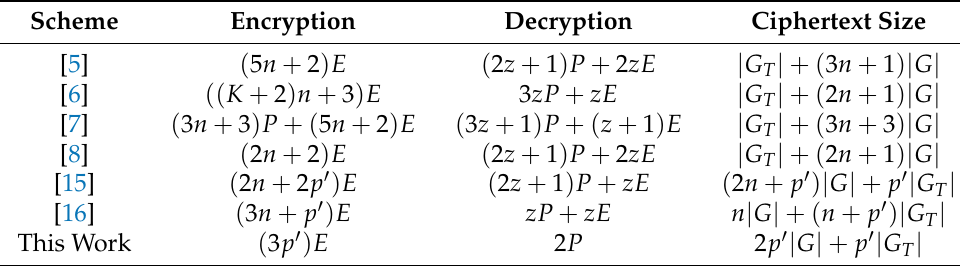
Table 4. Computational Costs Comparison with existing relevant schemes.